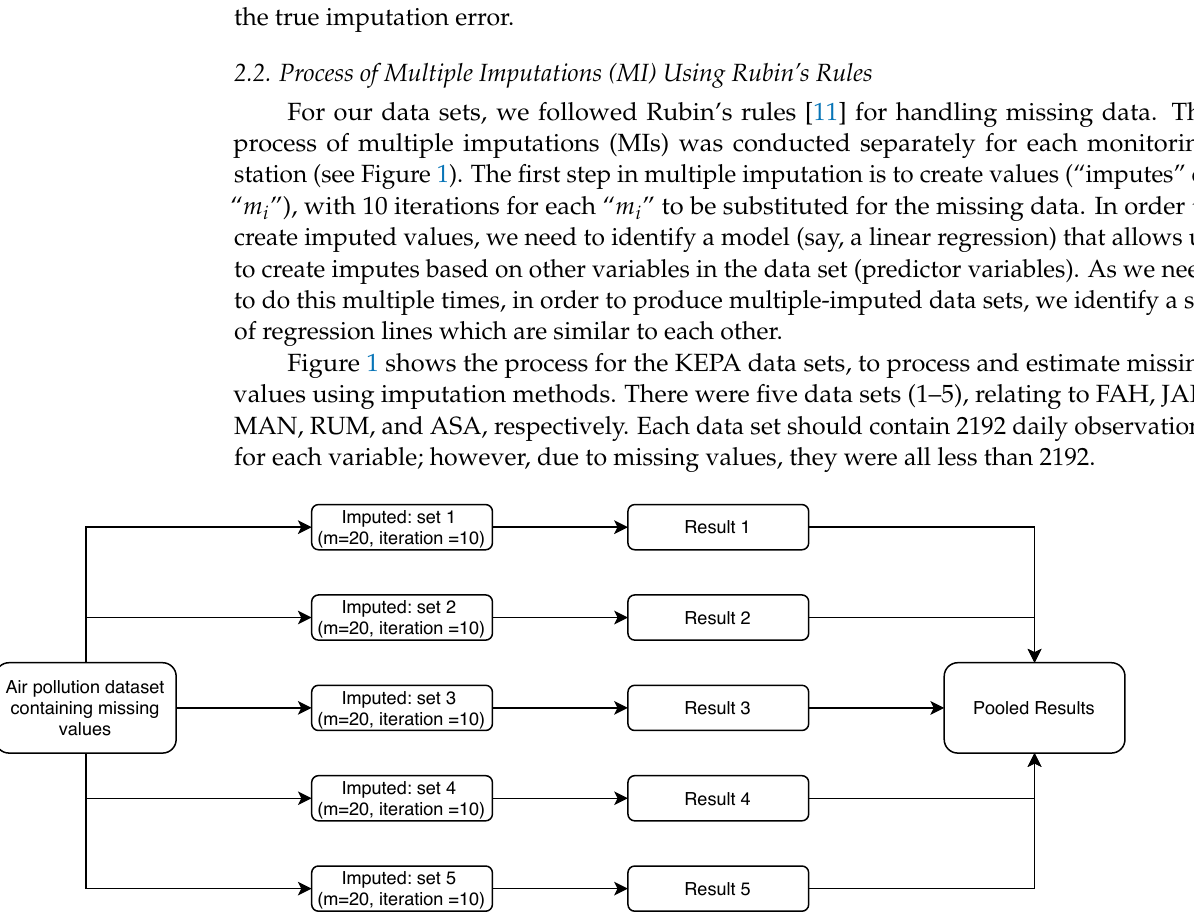
Figure 1. The steps of implementing multiple imputations for PM 10 , SO 2 , O 3 , CO , and NO 2 during 2012 to 2017, according to site location, in the State of